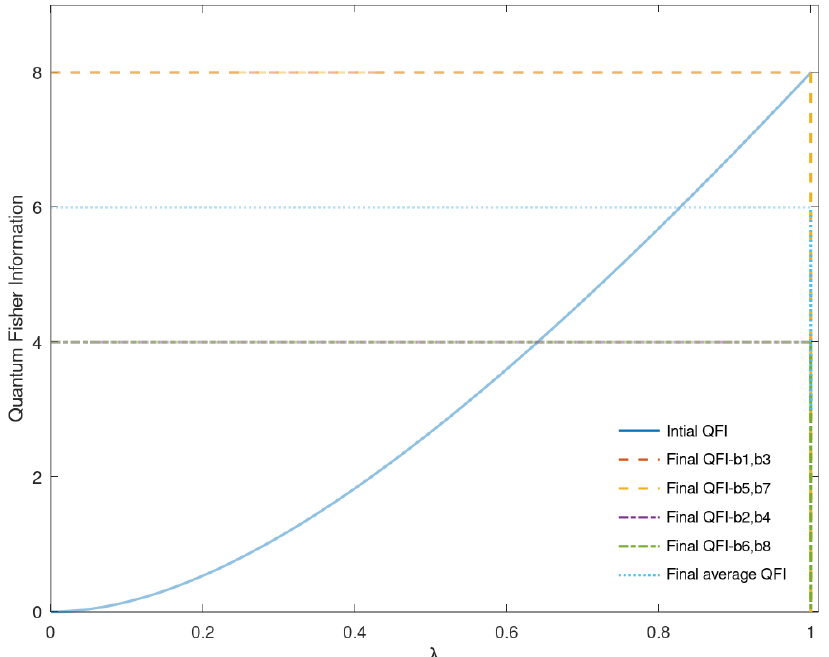
Figure 4. Final QFI attained by Bob’s state for a different measurement outcome of Alice, with the 3-qubit W state as a channel and the computational basis ( B (cid:48) ) as Alice’s measurement basis. The 2 solid blue line is the variation of QFI attained by Alice’s state. The red and yellow dashed line (coincided at QFI = 8 for λ = [ 0,1 ) ) represents Bob’s QFI when Alice’s registers as measured in states | 000 (cid:105) , | 010 (cid:105) , | 100 (cid:105) , or | 110 (cid:105) , and the violet and green dashed line (coincided at QFI = 4 for λ = [ 0,1 ) ) represents Bob’s QFI when Alice’s registers as measured in states | 001 (cid:105) , | 011 (cid:105) , | 101 (cid:105) , or | 111 (cid:105) . The sky-blue dotted line represents the average QFI of Bob’s final